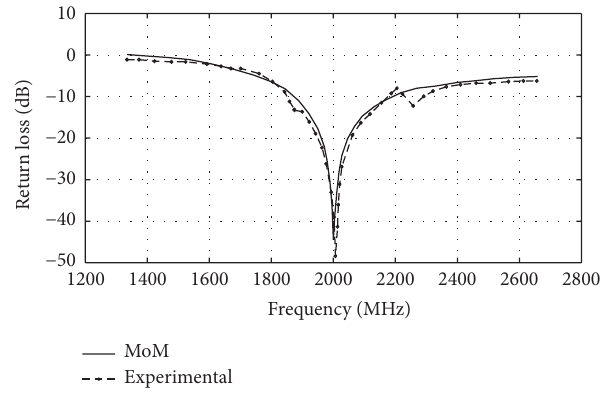
Figure 21: The return losses against the frequency obtained when feeding a strip dipole antenna using a split balun with a step transition of the inner conductor as optimized in the present work compared with the experimental results using vector network